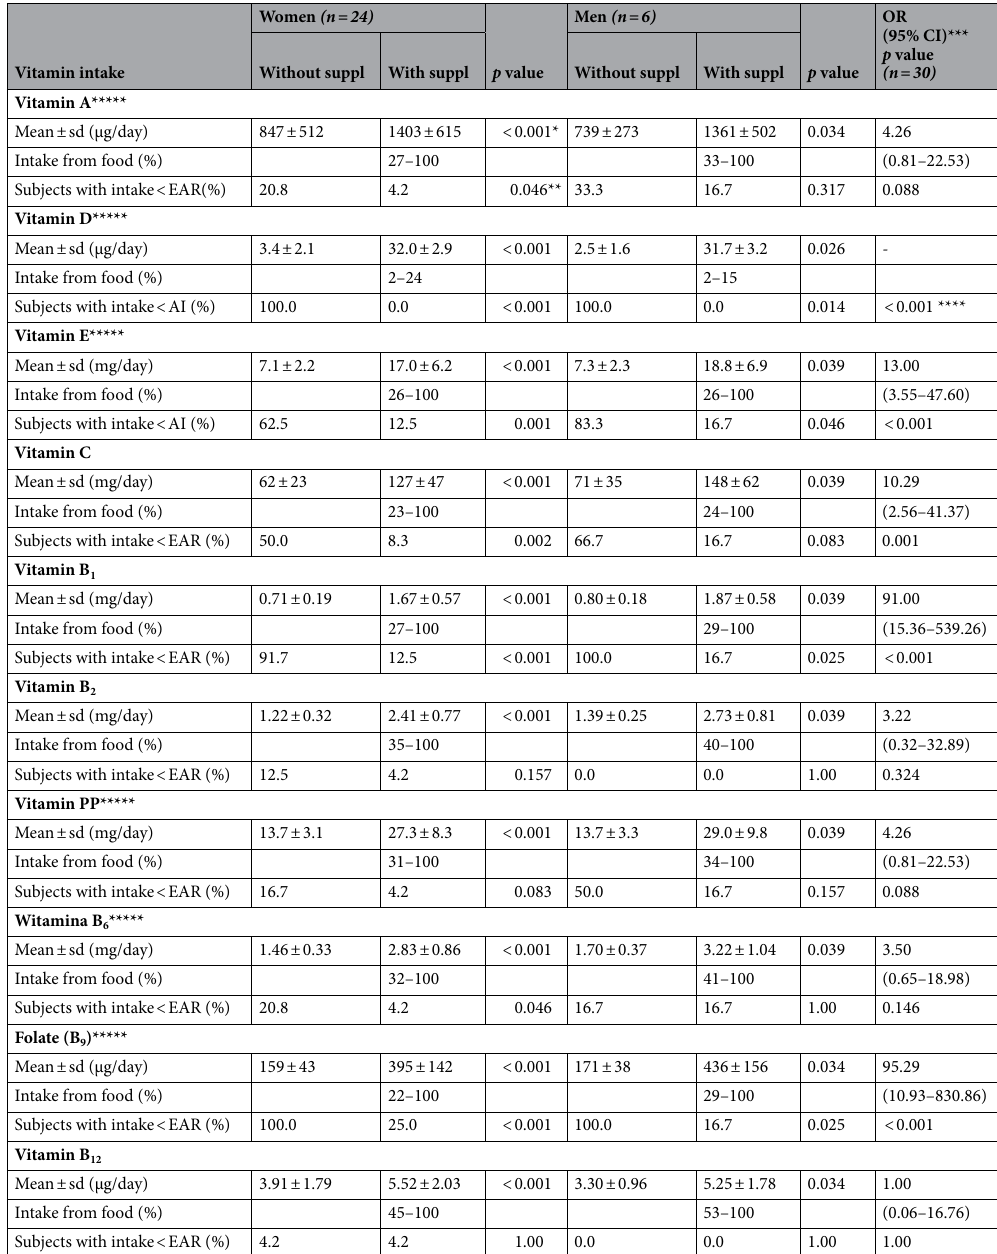
Table 1. Mean vitamin dietary intake with or without supplements in patients tested at 3, 6, and 9 months after bariatric surgery (SG). *Wilcoxon test; **McNemar test; ***odds ratio (95% confidence interval) for subject intake > EAR/AI with vs. without supplementation. p ≤ 0.05 statistically significant difference; EAR/ AI ref. value, ****—a perfect fit was obtained in the model, *****—the dietary and/or supplemental intake of vitamins did not exceed the tolerable upper intake level